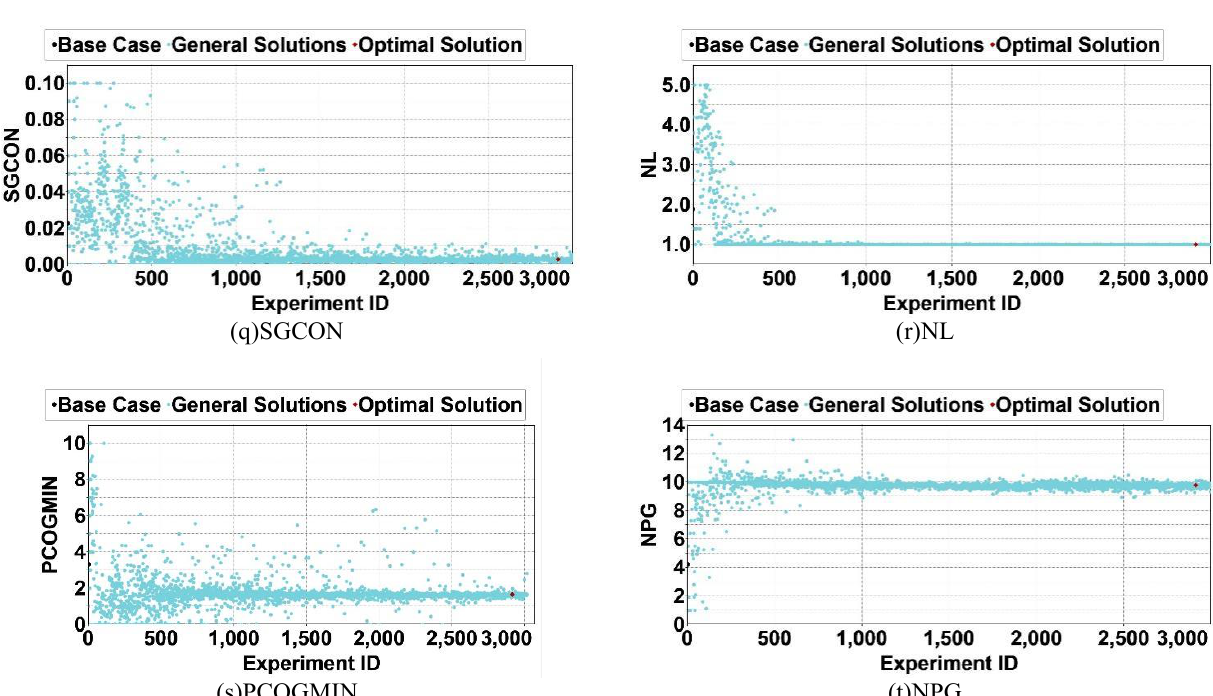
Figure 7—Distribution of parameters 3000 times during